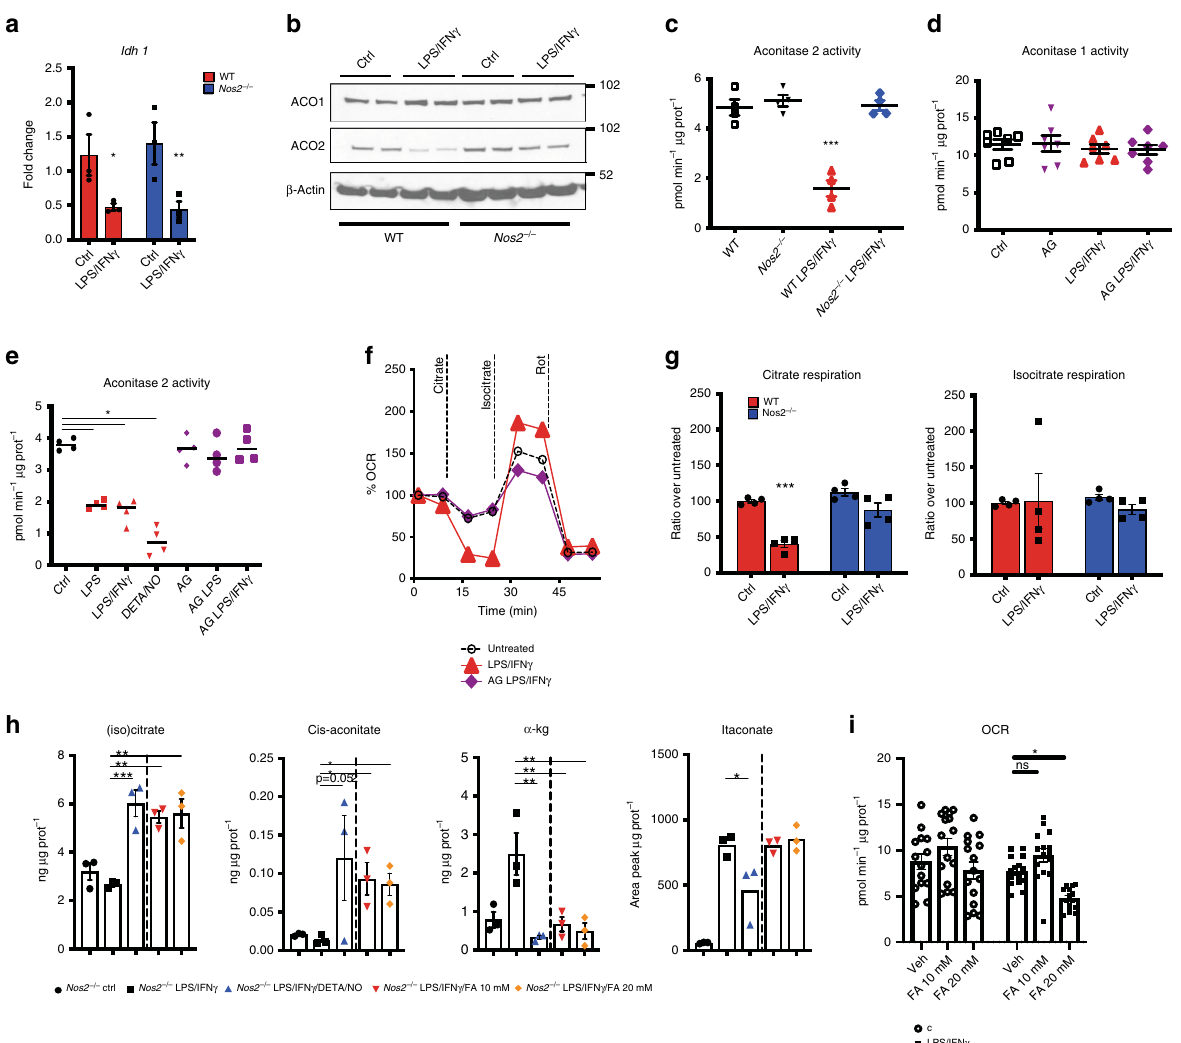
Fig. 2 The TCA Break is due to NO targeting of mitochondrial aconitase. a WT and Nos2 − / − BMDMs were stimulated for 8 h and mRNA was extracted from total cell lysates and analyzed by qPCR for Idh1 ( n = 6) (two-way ANOVA, Sidak ’ s post-tests; p -values = 0.033, 0.0093). b Whole-cell lysates of macrophages derived from two independent WT and Nos2 − / − mice were analyzed by western blot for cytosolic and mitochondrial aconitase (ACO 1-2). β -actin was used as loading control. c , d Aconitase 2 and total aconitase (aconitase 1) enzymatic activities in WT vs. Nos2 − / − BMDMs stimulated over night (O.N.). Where indicated cells were treated with NOS2 inhibitor Aminoguanidine (AG) 1 h prior to stimulation ( n = 6). e Damaging effect of endogenously produced or exogenously provided NO (DETA/NO) on activity of aconitase 2 ( n = 3). f Representative Seahorse analysis of oxygen consumption rates (OCR) in permeabilized WT and AG-pretreated BMDMs stimulated O.N. Citrate, tartronate, ADP and PMP were co-injected ( fi rst event marker). Isocitrate was injected at the second event marker and rotenone (rot) was injected lastly. g Quanti fi cations (percentage relative to ctrl cells) of exogenous citrate and isocitrate-dependent state 3 OCR in WT vs. Nos2 − / − ( n = 6). Data were analyzed by one-way ( c – e ) or two-way ANOVA ( f , g ), ( p < 0.0001) with Tukey ’ s post-tests. h Nos2 − / − BMDMs were stimulated with LPS + IFN γ in the presence of either DETA/NO (500 μ M) or FA. Metabolites were quanti fi ed by ESI-LC/MS-MS and are reported as normalized total ng or peak area. Data ( n = 6) were analyzed by one-way ANOVA with Dunnett ’ s post-tests. i Bar graphs showing quanti fi ed, protein normalized, basal OCR from stress tests of Nos2 − / − macrophages treated with vehicle or FA 1 h prior to O.N. stimulation. Data ( n = 3) were analyzed by two-way ANOVA with Sidak ’ s post-tests. All error bars display mean ± SEM. Source data are provided as a Source Data fi